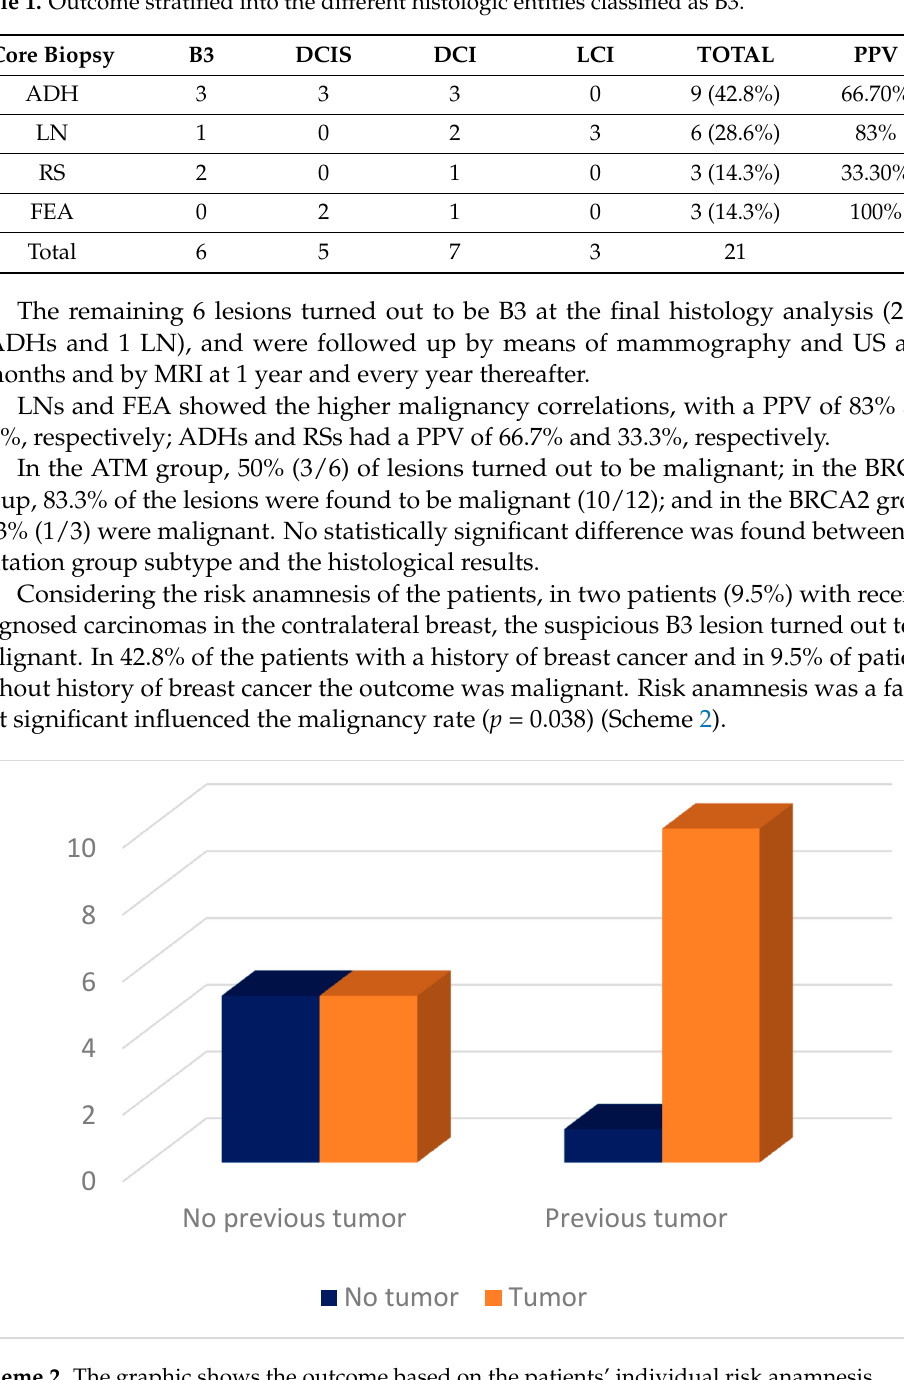
Table 2. Outcome strati fi ed by patient